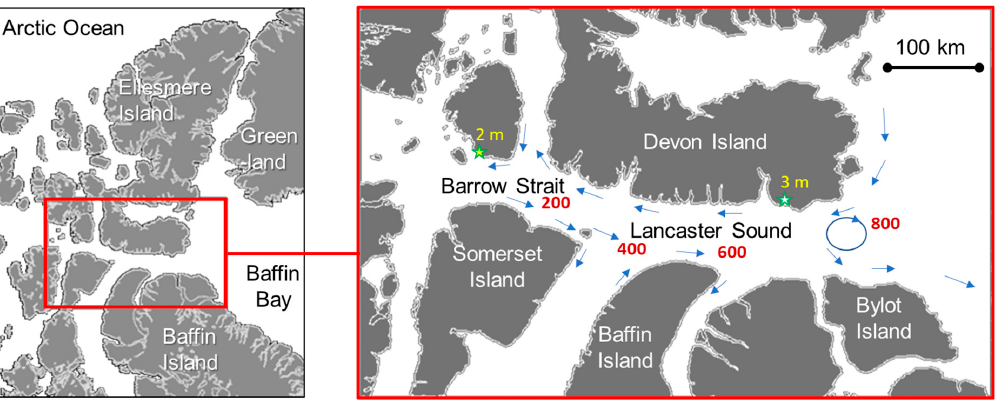
Figure 1. Location of Lancaster Sound and Barrow Strait. Surface current direction is shown by the blue arrows, while depth in meters is indicated in red. Maximum tidal amplitudes at Dundas Harbor (3 m) and Resolute (2 m) are depicted with stars.